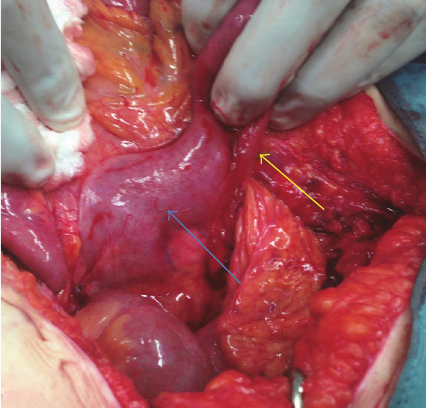
Figure 10: Duodenal compression of the third part (blue arrow) and DJ flexure mobilized (yellow arrow) (Case Report